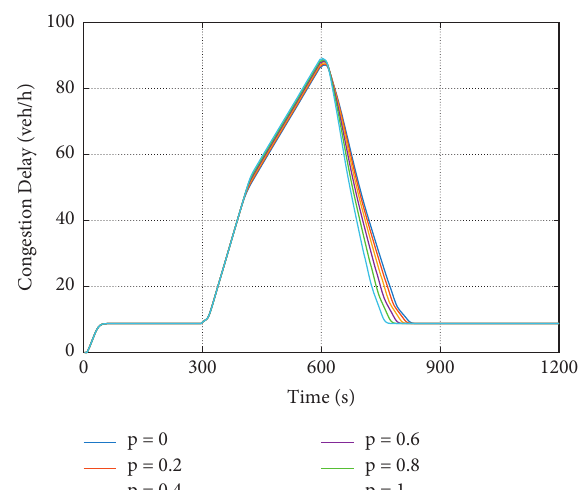
Figure 19: Congestion